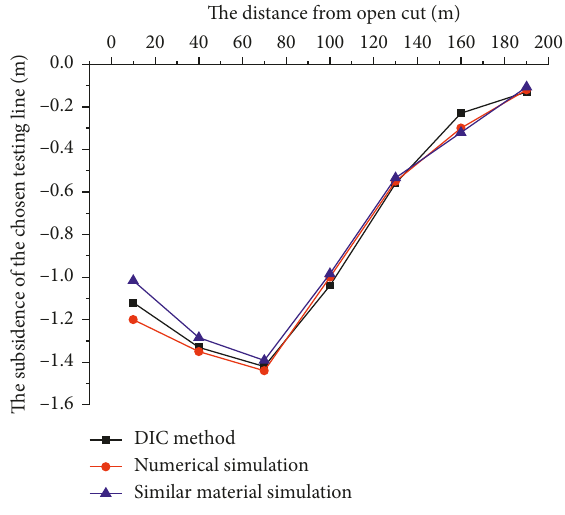
Figure 14: Accuracy